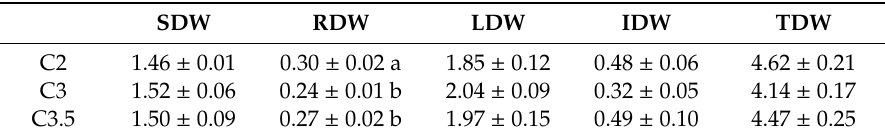
Table 2. Leaf area, internode length, leaf, shoot, and flower numbers and width, and leaf length for the C2 (fertigation EC 2.0 dS m − 1 ), C3.0 (fertigation EC 3.0 dS m − 1 ), and C3.5 (fertigation EC 3.5 dS m − 1 )